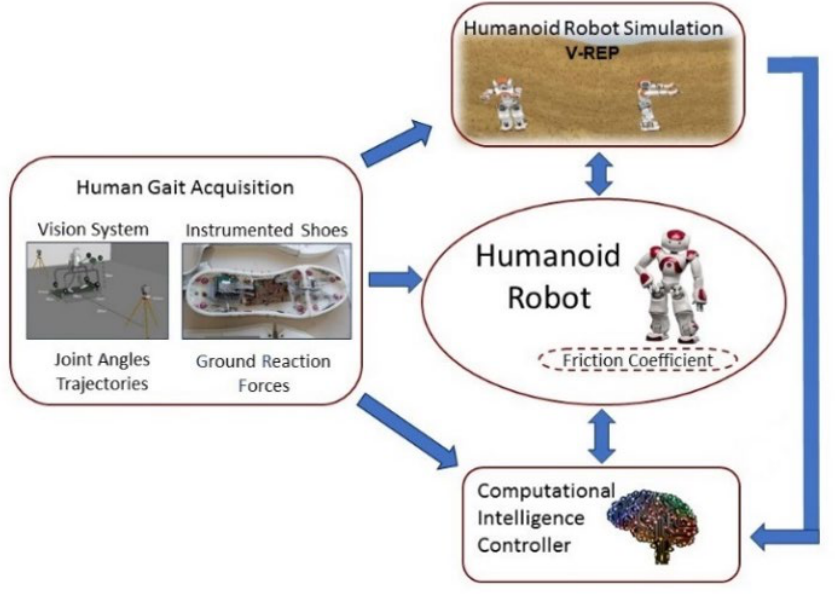
Figure 2. NAO robot control system. The humanoid robot simulator (V-REP) implements the various gaits provided by HRSP and the ZMP trajectories obtained from the human gait acquisition system. The simulation results are used to train the computational intelligent balance controller. The controller changes the gait parameters based on measured foot-floor friction coefficient and corrects the leg joints based on the desired ZMP